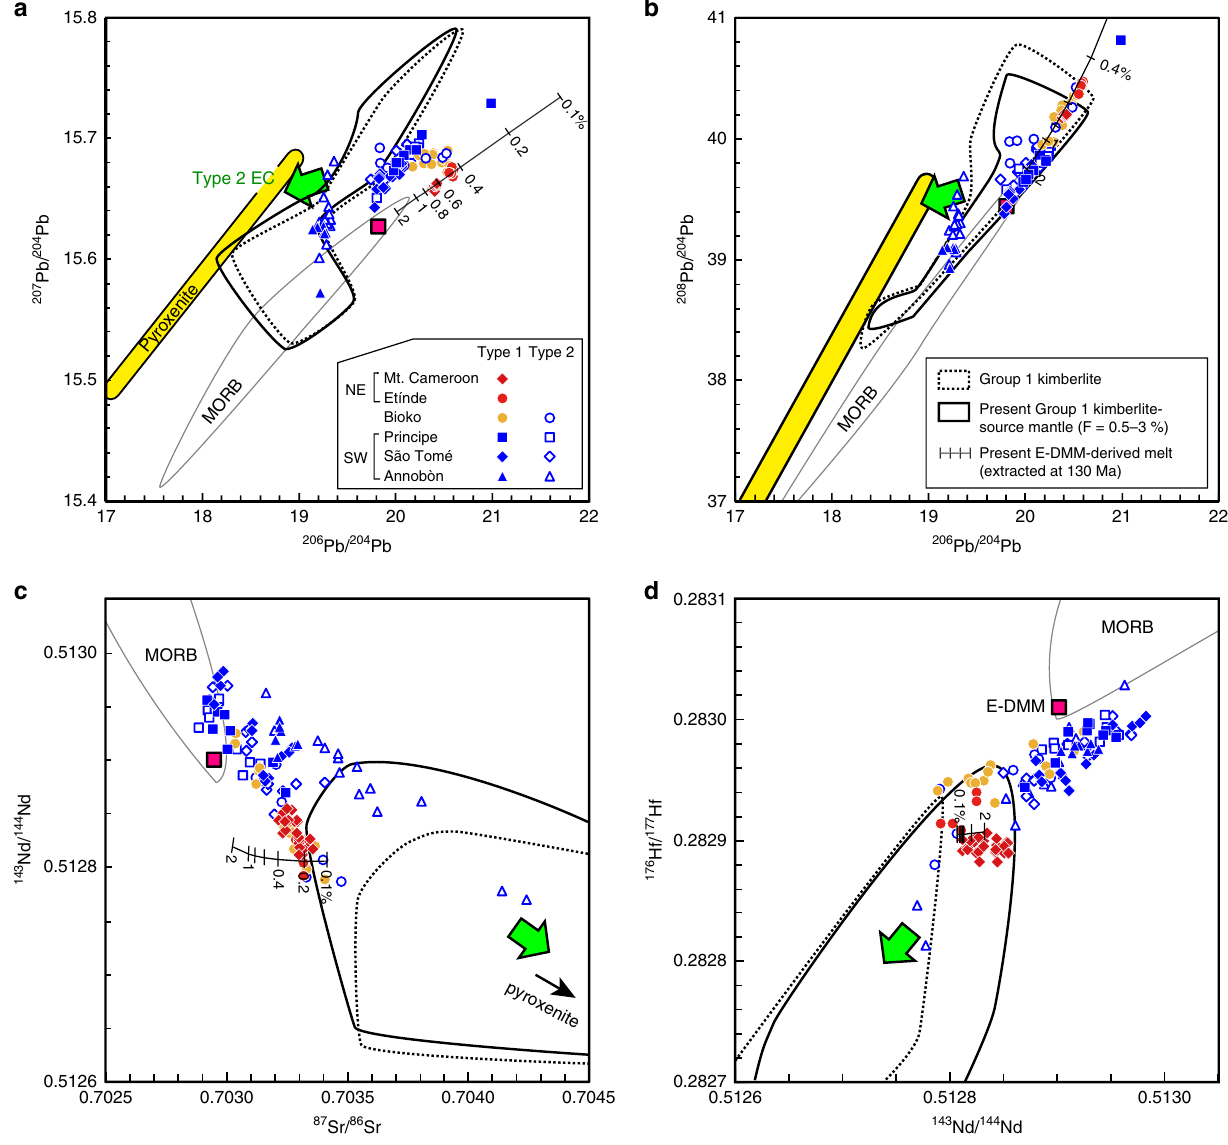
Fig. 3 Sr – Nd – Hf – Pb isotopic compositions of Cameroon volcanic line lavas. a 206 Pb/ 204 Pb vs. 207 Pb/ 204 Pb, b 206 Pb/ 204 Pb vs. 208 Pb/ 204 Pb, c 87 Sr/ 86 Sr vs. 143 Nd/ 144 Nd, and, d 143 Nd/ 144 Nd vs. 176 Hf/ 177 Hf. The ranges for the isotopic compositions of Group 1 kimberlite and of the calculated Group 1 kimberlite-source subcontinental lithospheric mantle (SCLM) are shown in black broken and solid curves, respectively. The source data of the compiled values for Group 1 kimberlites erupted between 71 and 114 Ma are provided in ref. 66 . The calculated present-day isotopic compositions of the enriched part of the depleted mid-ocean ridge basalt source mantle (E-DMM)-derived melt, which formed during the continental breakup at 130 Ma are shown with black lines (see Supplementary Fig. 1 for further details). The digits in the black lines denote the degree of partial melt at 130 Ma. The yellow region is the pyroxenite vein/layer xenolith derived from the SCLM of the Congo craton 36 . The 2 SD error bars are smaller than the symbols for Cameroon volcanic line